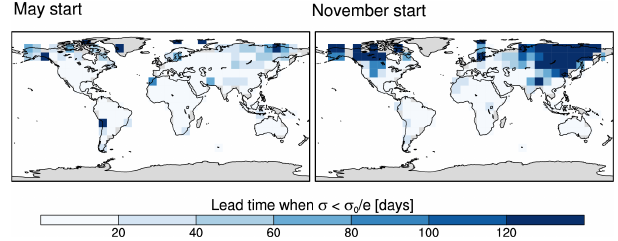
Figure 2. Average date of memory loss in the top model soil level, estimated from H-TESSEL (default parameter set), for May (left) and November (right) start dates.